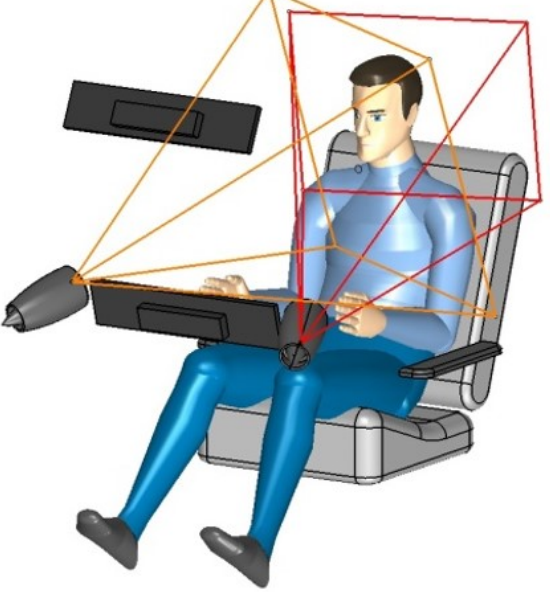
Figure 3. Schematic 3D view of the interior. The driver is facing the dashboard, including the two IR cameras. The overlapping viewing cones of both cameras are shown in orange and red. (Permission by Institute for Automotive